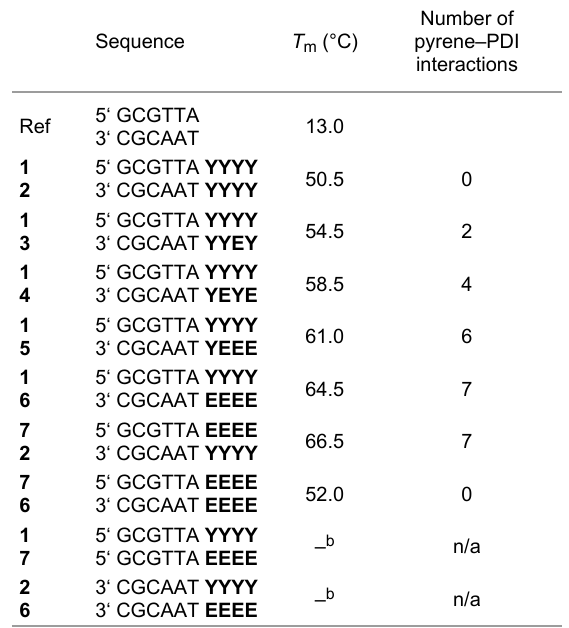
Table 1: T m values of the hybrids determined by thermal denaturation experiments. a